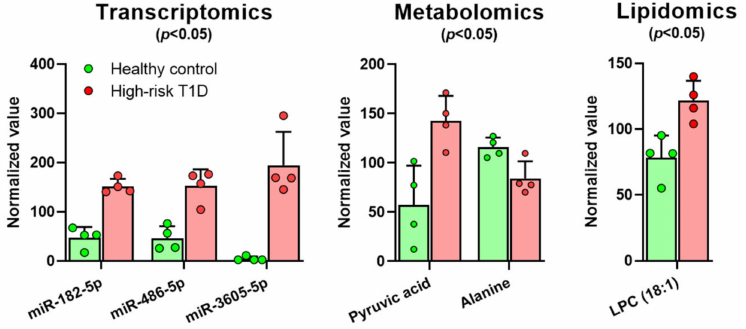
Figure 2. Independent analyses in the individual datasets from multi-omics reveal modest differences in the transcriptome, metabolome, and lipidome of high-risk T1D subjects compared to healthy controls with only a few significantly different features. A comparison between high-risk T1D subjects (red/pink) and healthy controls (green; n = 4 each), using each omics-type dataset pooled from each group, was performed by t -test with correction for multiple comparisons with the Holm– Sidak method. Shown are all miRNAs, lipids, and metabolites that had significant differences between the two groups ( p <